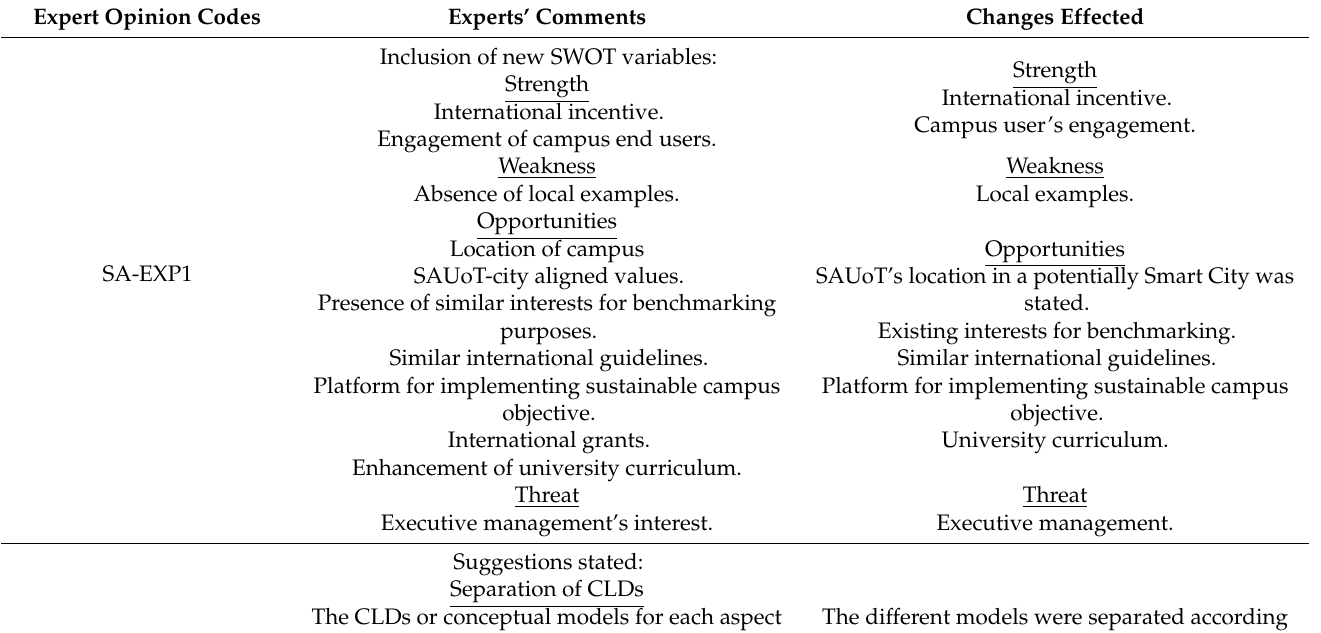
Table 4. Summary of findings from experts’